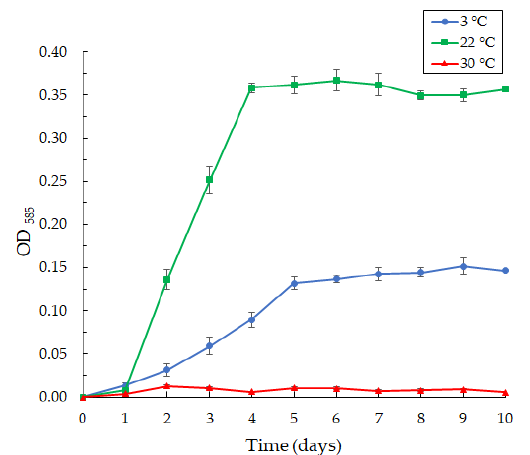
Figure 6. The curves of violacein production by the Janthinobacterium sp. SLB01 strain at 3, 22, and 30 °C in LB broth, OD 585 . Results are shown as mean values of three independent experiments performed.